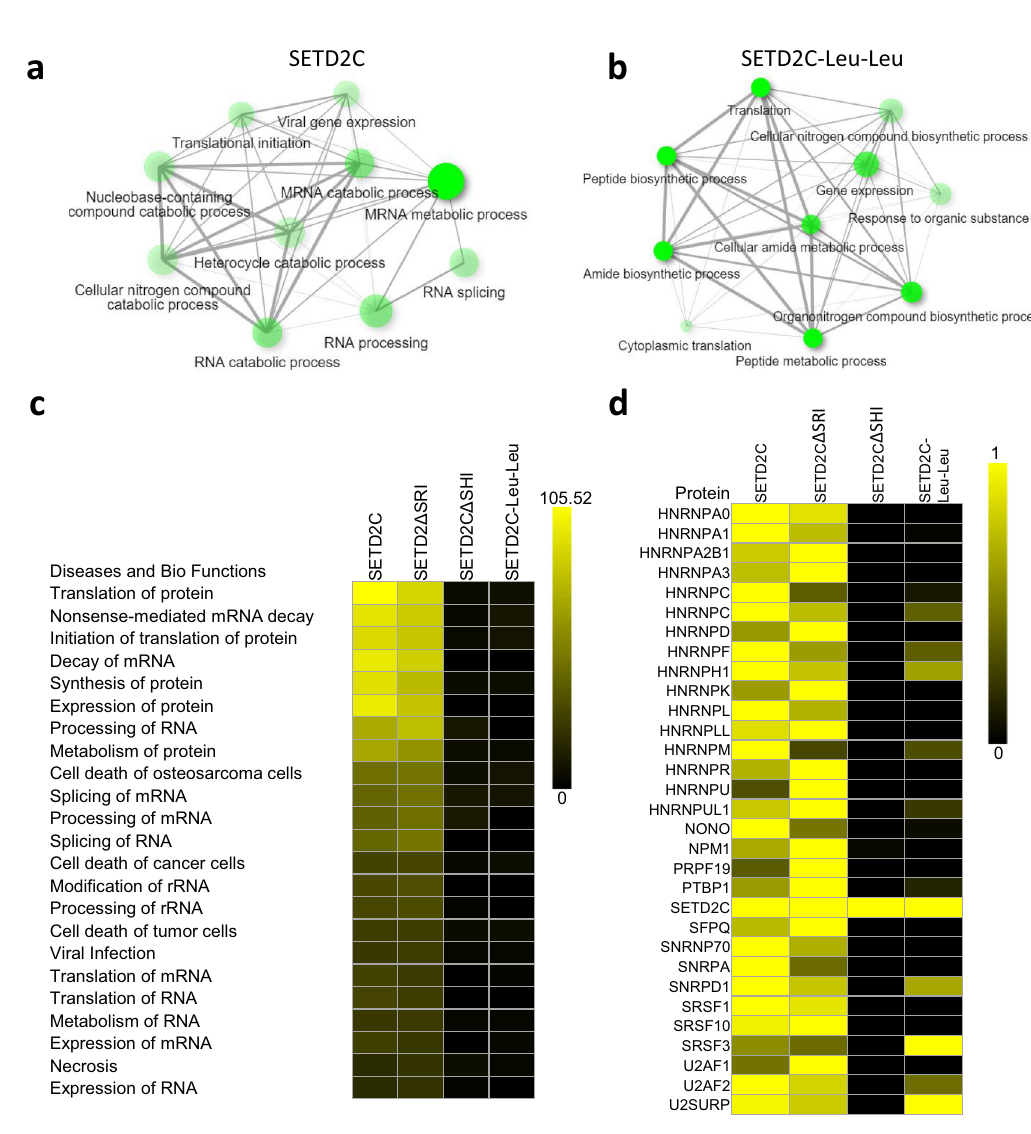
Fig. 7 Mutating Leu – Leu in the SHI domain results in decreased interaction of SETD2 with RNA-binding proteins. a , b GO-term analysis of proteins using ShinyGO (http://bioinformatics.sdstate.edu/go/) identi fi ed by MudPIT in the af fi nity-puri fi cation of SETD2C and SETD2C-LL mutant. c , d Heat maps showing the enrichment of pathways in the IPA (Ingenuity Pathway Analysis) and proteins in MudPIT analysis. The enrichment of proteins is normalized to the bait four conserved aromatic protein side chains and two bases, degenerate RNP consensus sequences, RNP-1 and RNP-2 51,52 . resulting in the binding of RNA to the β -sheet surface. Our crystal The RRM contacts RNA using the RNP-1 and RNP-2 consensus structure revealed that the binding of SETD2 occurs in a very sequences, which are present on the β 3 and β 1 strands, respec- different fashion where its Leu – Leu inserts its side chains into the tively. This involves primarily hydrophobic interactions between